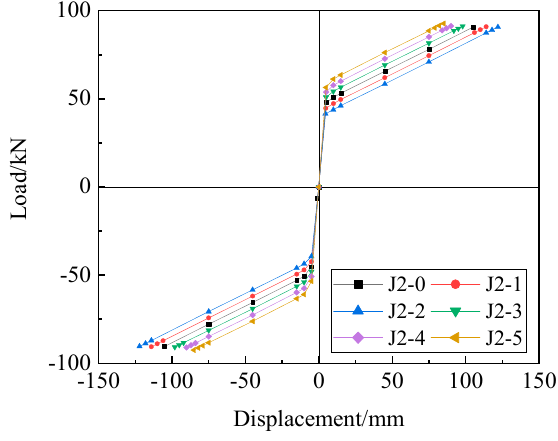
Figure 21. Envelope curves of joints. Stress Variation Curves of Steel